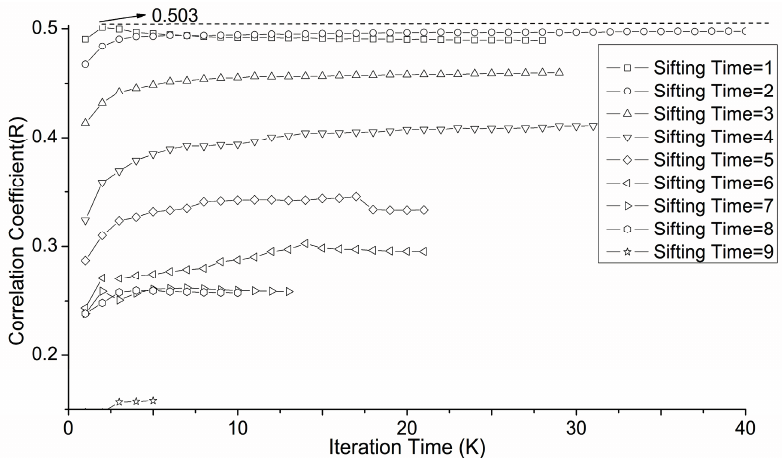
Figure 5. Correlation coefficients under different sifting and iteration processes. To obtain